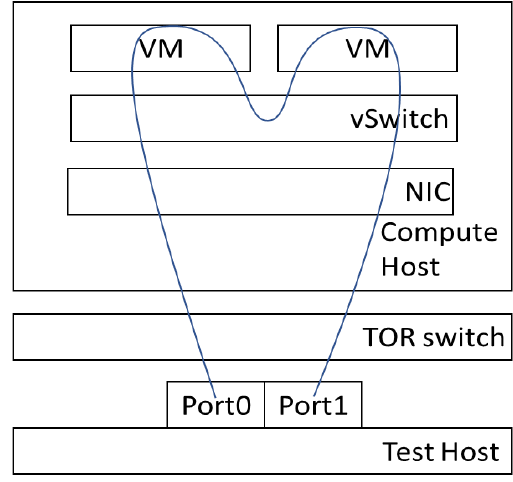
Figure 7. Packet path in PVVP scenario.